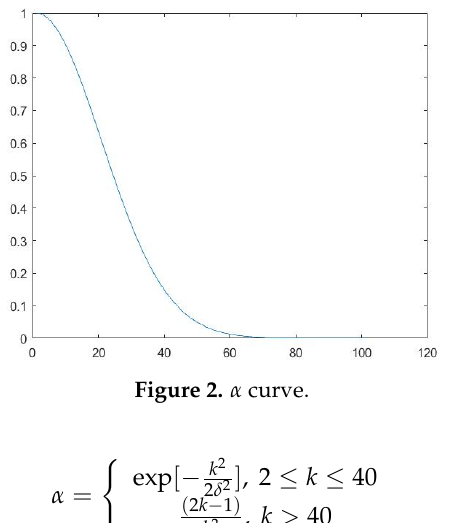
Figure 2. α Figure 2.  curve.